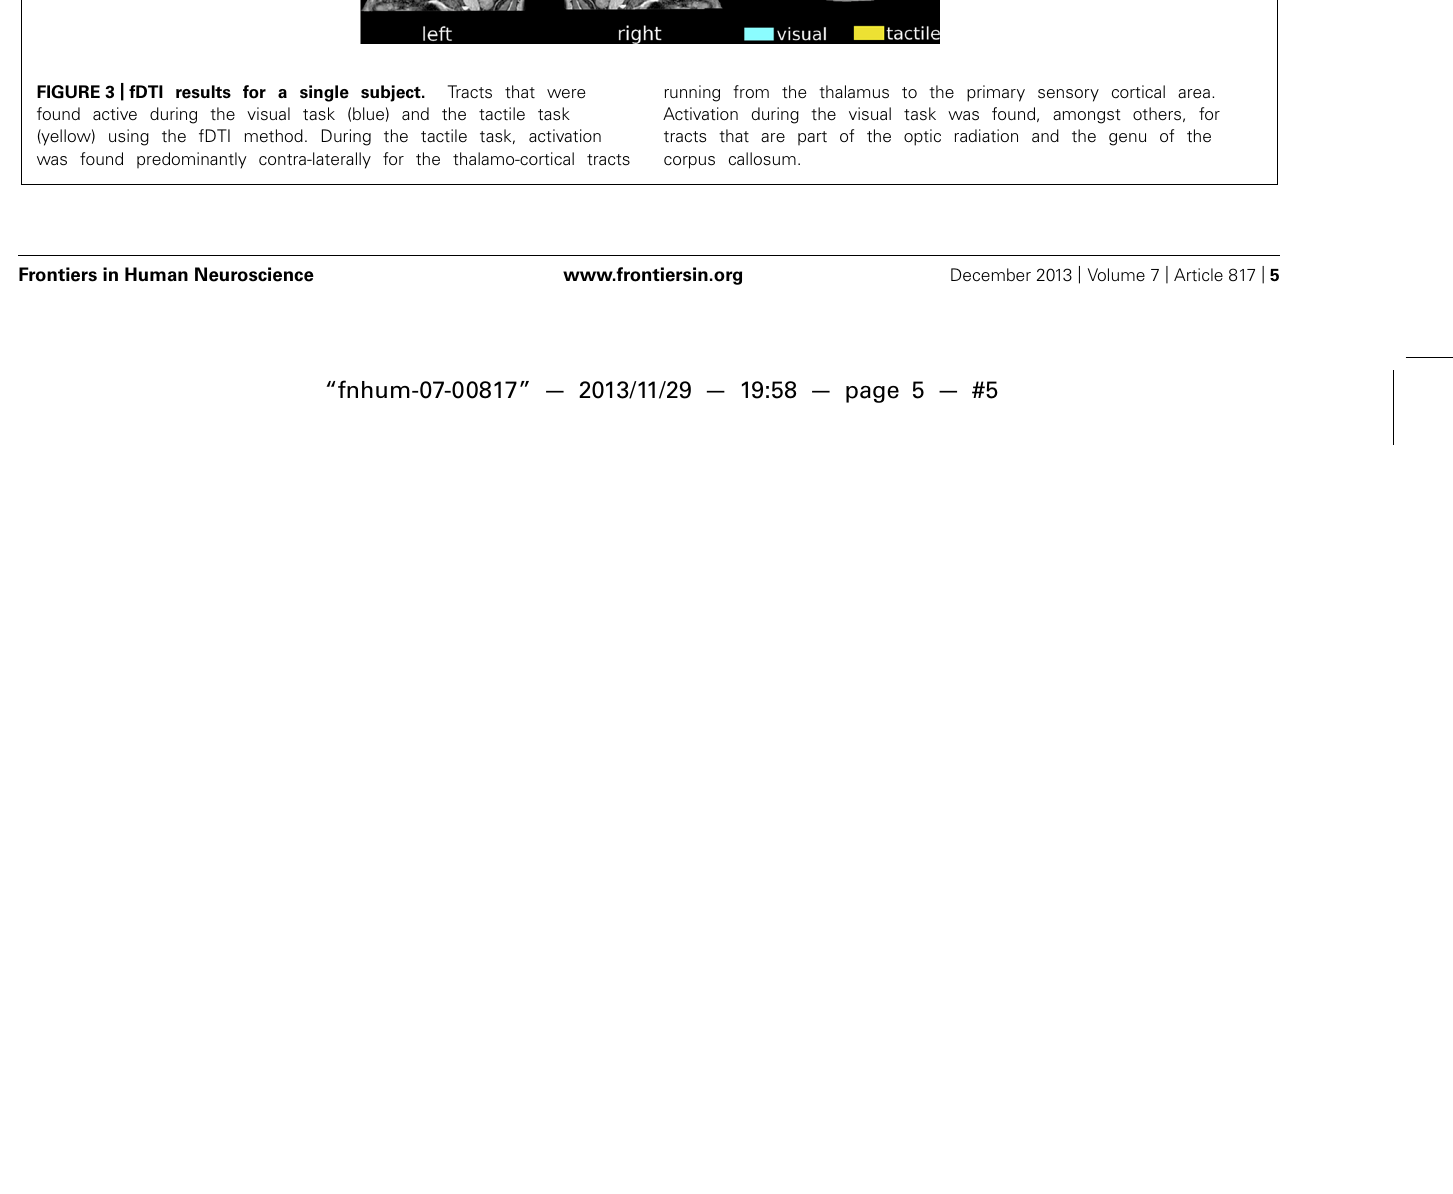
running from the thalamus to the primary sensory cortical area. Activation during the visual task was found, amongst others, for tracts that are part of the optic radiation and the genu of the corpus